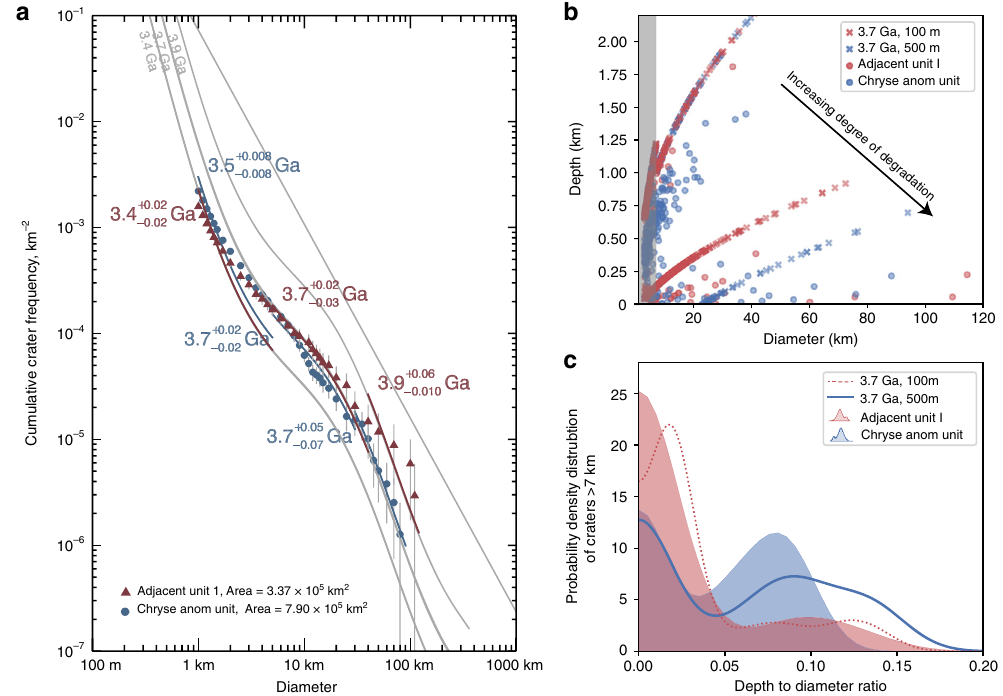
Fig. 3 Impact crater size frequency and crater depth to diameter ratio compared to crater accumulation models. a Cumulative fi t on the crater size- frequency diagram showing the periods of major resurfacing events in the Chryse anomaly unit (blue) and the Adjacent unit 1 (red) using Craterstats 23 . The isochrons of 3.4, 3.7, and 3.9 Ga are plotted in grey lines, calculated based on the crater production function 24 and chronology function 25 . The tabulated data are attached in the Supplementary Tables 2 – 3. b, c Modeled impact crater morphology and probability density for a common instantaneous resurfacing event around 3.7 Ga with zero obliteration rate, compared to observations. b The depth-diameter relationship of modeled results (crosses) compared to observations (circles) with craters smaller than 7 km masked in the shaded zone. c The probability density distribution of depth to diameter ratio as a proxy for the relative abundance of modeled pristine and fi lled impact craters (non-shaded) compared to observations (shaded). The distribution is calculated for craters larger than 7